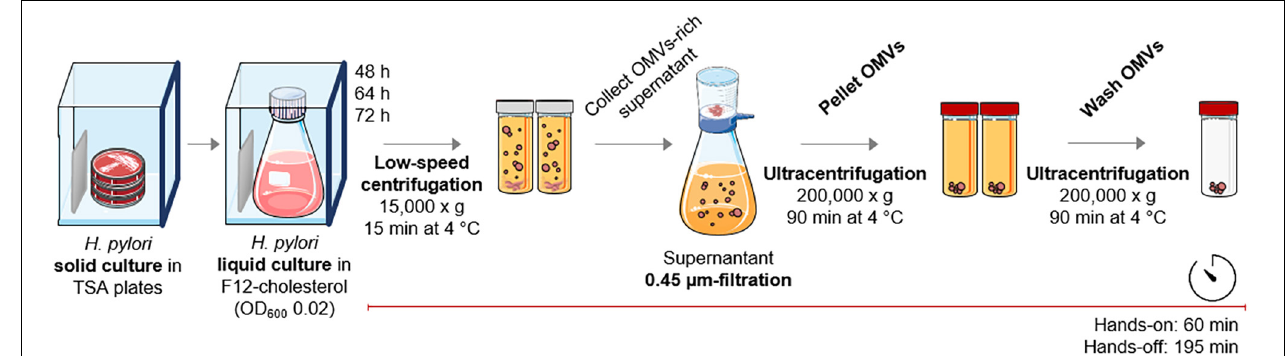
FIGURE 2 | Outline of the OMVs isolation method from Helicobacter pylori cultures in F12-cholesterol medium. After the establishment of the liquid bacterial culture, the protocol for OMVs isolation includes one low-speed centrifugation, a 0.45 µ m-filtration of the bacteria-free supernatant, and two ultracentrifugations for the recovery and wash of OMVs, comprising 60 min of hands-on period and 195 min of hands-off period (see details in Materials and Methods section). This figure used elements from Servier Medical Art